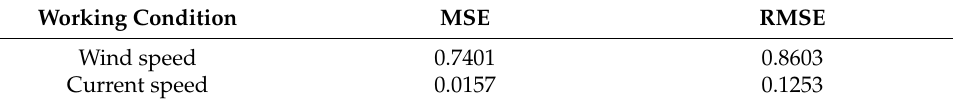
Table 2. Predicted results of working condition.